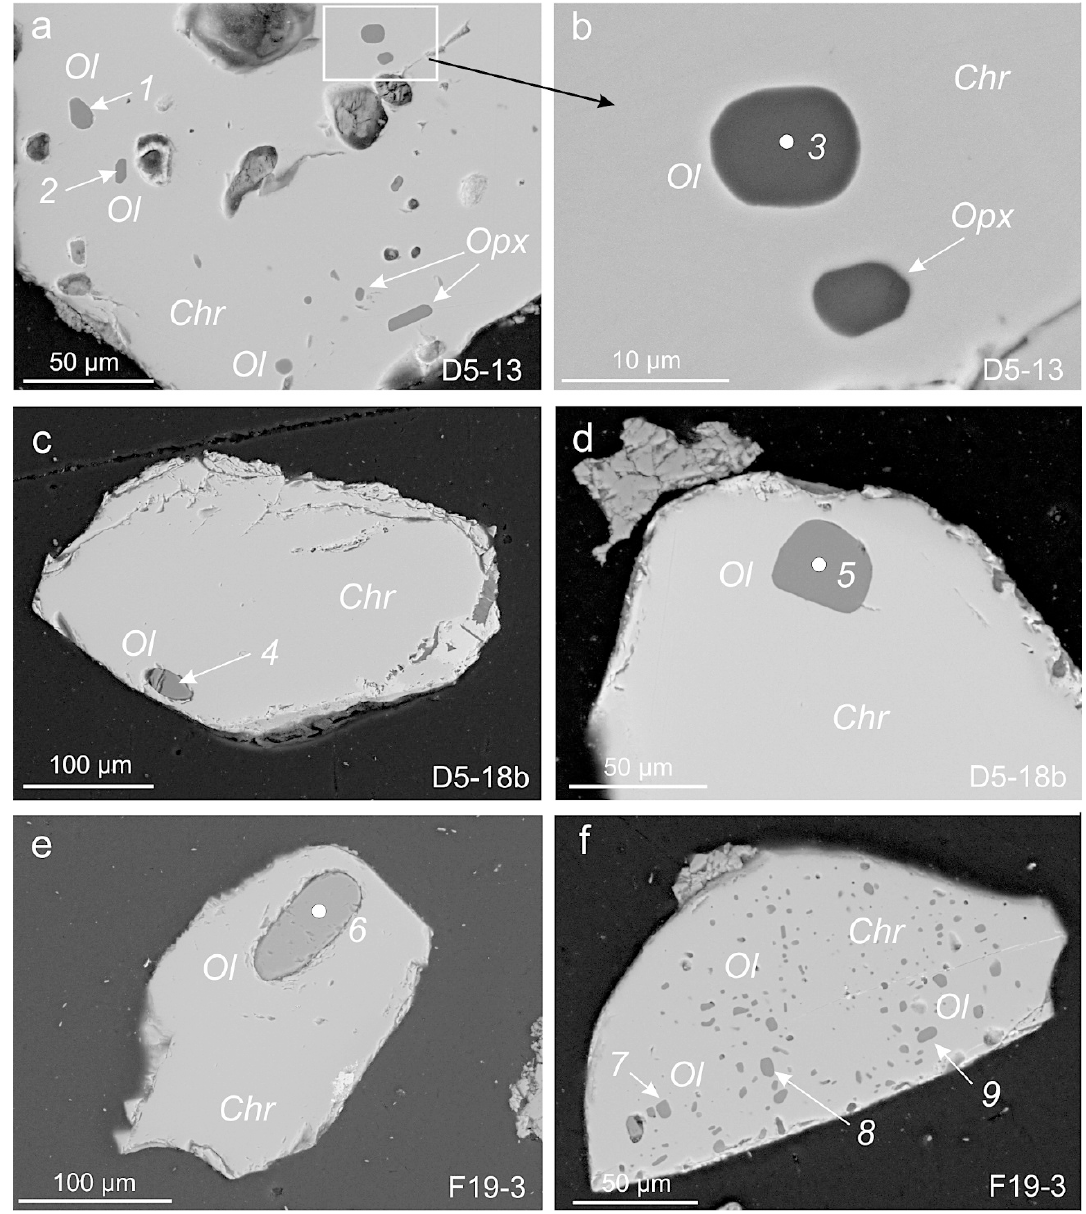
Figure 11. BSE images of monomineralic olivine (Ol) and orthopyroxene (Opx) inclusions in chromspinels (Chr) from the Sabantuy paleoplacer (samples D 5 -13, D 5 -18b, F 19 -3): ( a ) numerous chromspinel-hosted olivine and orthopyroxene inclusions, ( b ) olivine and orthopyroxene inclusions, enlarged area of figure ( a ), ( c,d ) olivine inclusions, ( e ) rounded olivine inclusion, ( f ) abundant olivine inclusions in chromspinel. Note: the numbers indicate the points of the compositions presented in Table 3.